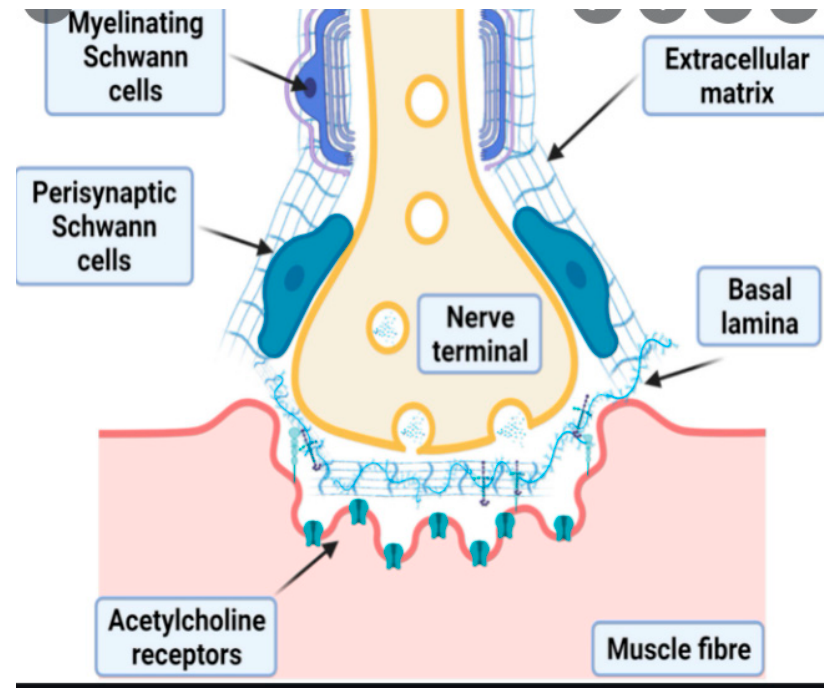
Figure 1. Positioning of the peri-synaptic Schwann cell at the neuromuscular